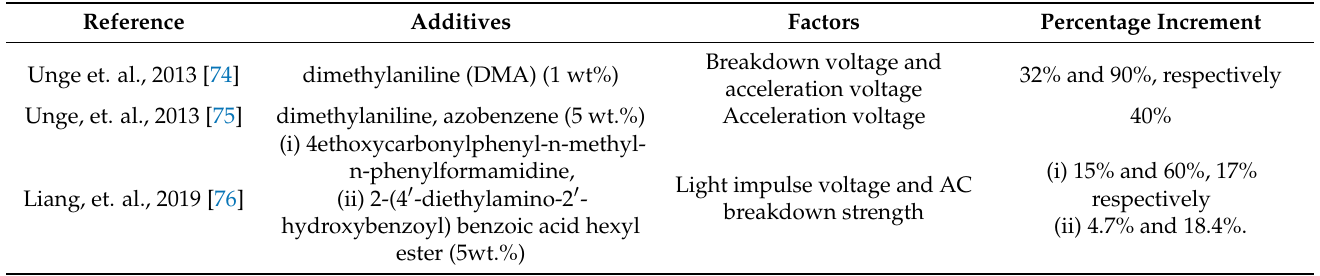
Table 3. Some additives used in the literature and their effect on natural